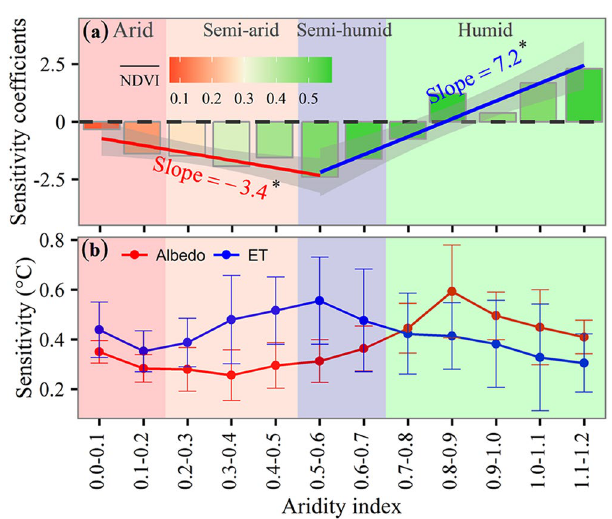
Figure 3. Sensitivity of the temperature trend to NDVI trend ( a ) and temperature sensitivity of evapotranspiration (ET)/albedo to the NDVI changes (every 0.1 increment) across hydroclimatic regimes ( b ). In ( a) , the color for each bar indicates the mean growing season NDVI. Hydroclimatic regimes are represented by the aridity index. Pixel values were averaged using a bin (0.1) for the aridity index. The value for each bar was calculated using the mean sensitivities for each bin, with statistical significance at p < 0.05. The solid line represents the least squares regression. The labeled slopes indicate change in sensitivity of the temperature trend to NDVI trend corresponding to per 0.1 increase in aridity index, and that with an asterisk are significant ( p <